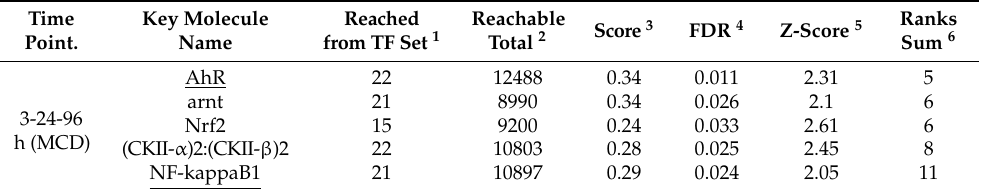
Table 1. Putative key molecules responsible for regulation of the DEGs related to the myeloid cell differentiation (MCD group) at 3, 24 and 96 h after ATRA treatment. Time